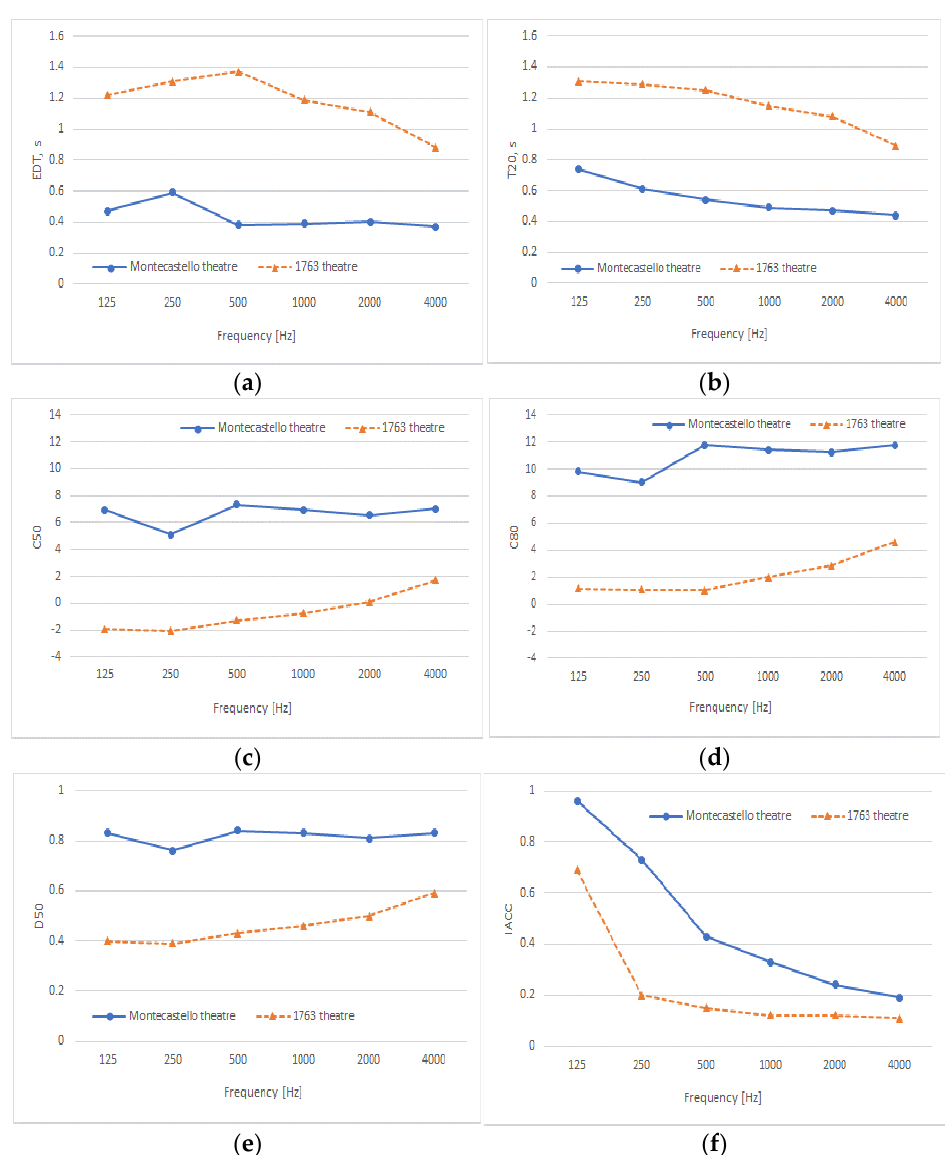
Figure 14. Monte Castello di Vibio theatre vs 1763 theatre main acoustic parameters.